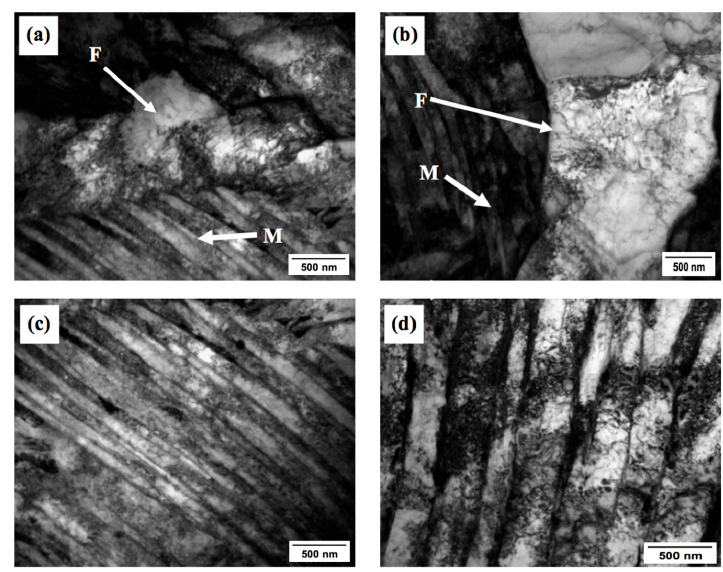
Figure 4. ( a ) Transmission electron microscopy (TEM) bright-field (BF) micrograph showing the ferritic microstructure (F) upon the FRT of 850 °C; ( b ) 700 °C; ( c ) Martensite lath structures (M) upon the FRT of 850 °C and ( d ) 700 °C.